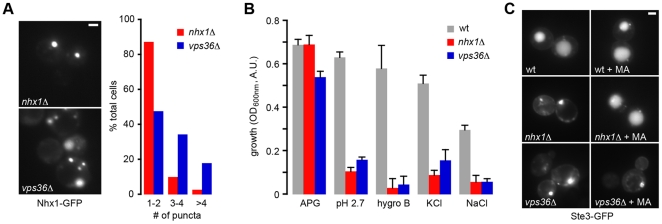
Transporter dysfunction in vps36Δ cells.(a) Nhx1 is mislocalized in vps36Δ cells. Micrographs show the location of Nhx1-GFP in nhx1Δ or vps36Δ cells transformed with the 2 µ plasmid pRin82 containing NHX1:GFP behind its endogenous promoter. Bar, 2 µm. The number of Nhx1-GFP stained puncta per cell was quantified; >100 cells were analyzed for each strain. (b) vps36Δ phenocopies nhx1Δ. Growth of wild type BY4742 (wt), nhx1Δ or vps36Δ cultures was measured after 19 hrs at 30°C under control conditions (APG, pH 4.0), acid stress (pH 2.7), or in the presence of 10 µg/ml hygromycin B (Hygro B), 1.5 M KCl or 1.5 M NaCl. Bars represent mean +/− S.E.M. (c) The pH homeostasis defect in nhx1Δ is downstream of Vps36 function. Micrographs show the cellular location of Ste3-GFP in wild type BY4742 (wt), nhx1Δ or vps36Δ cells grown in APG pH 4.0 medium at 30°C with or without methylamine (MA, 10 mM) treatment. Note that pH amelioration fails to correct trafficking dysfunction in vps36Δ cells. Bar, 2 µm.